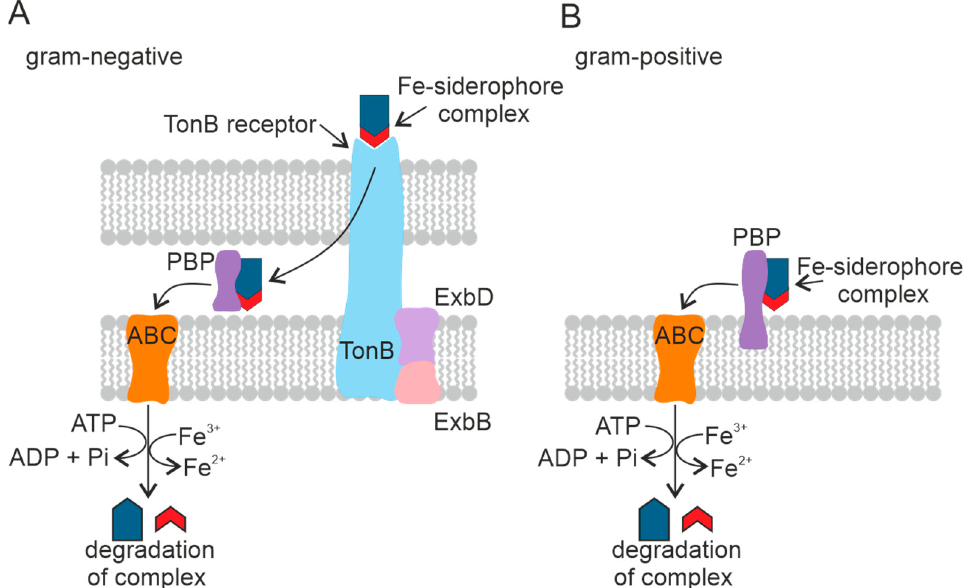
Figure 6. Mechanism of transport of the Fe–siderophore complex into the cell in Gram-negative ( A ) and Gram-positive ( B ) PGPB. Periplasmic binding protein (PBP), ATP-binding cassette transporter (ABC). The TonB-dependent receptor is a complex of three proteins.